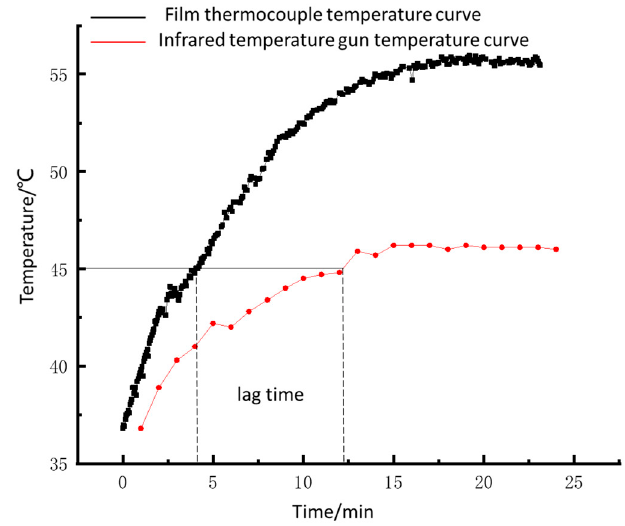
Figure 16. Spindle speed 400 r/min shaft temperature curve.